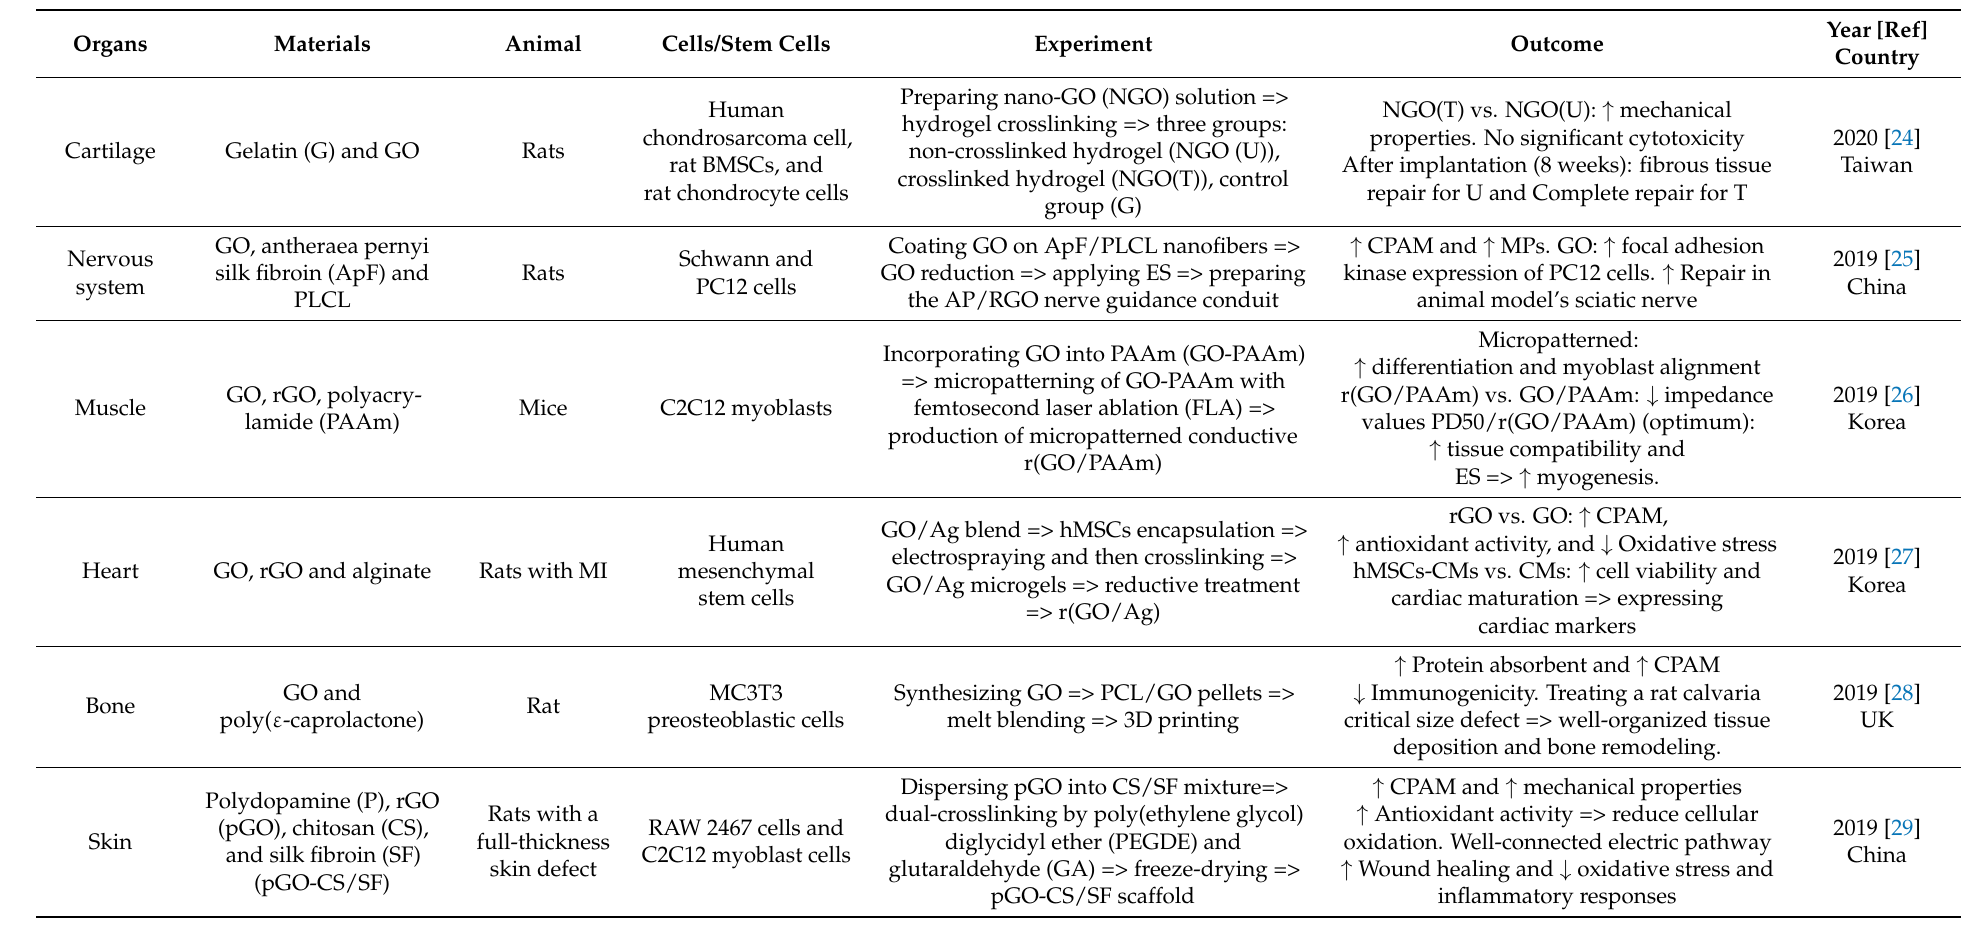
Table 1. Summary of preclinical studies of graphene-oxide-based materials in tissue engineering from